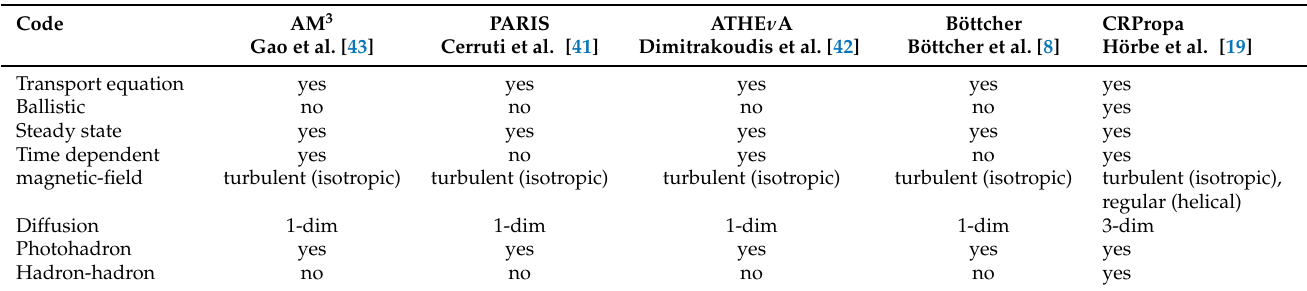
Table 1. Basic properties of state-of-the-art blazar propagation codes. A detailed comparison of the codes in this table for blazar hadronic models was presented by Cerruti et al. [40], with the exception of CRPropa